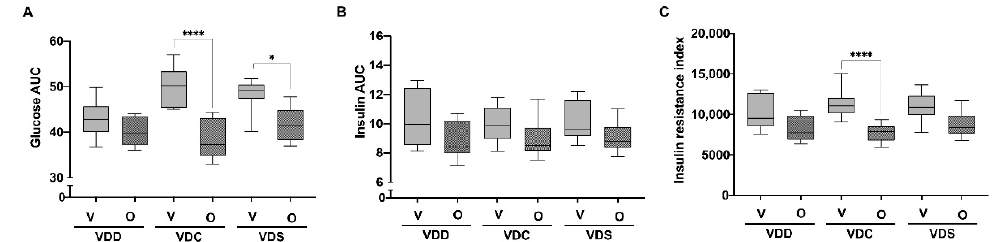
Figure 2. Area under the curve (AUC) analysis obtained from OGTTs for ( A ) glucose and ( B ) insulin and ( C ) insulin resistance index which is calculated by multiplying the AUC of glucose and insulin. Data are shown as a box (5th and 95th and mean value) and whisker (minimum and maximum values) plots ( n = 8 per group). * p ≤ 0.05; **** p ≤ 0.005. VDD, Vitamin D Deficiency; VDC, Vitamin D Control; VDS, Vitamin D supplemented; O, Olanzapine; V, Vehicle.